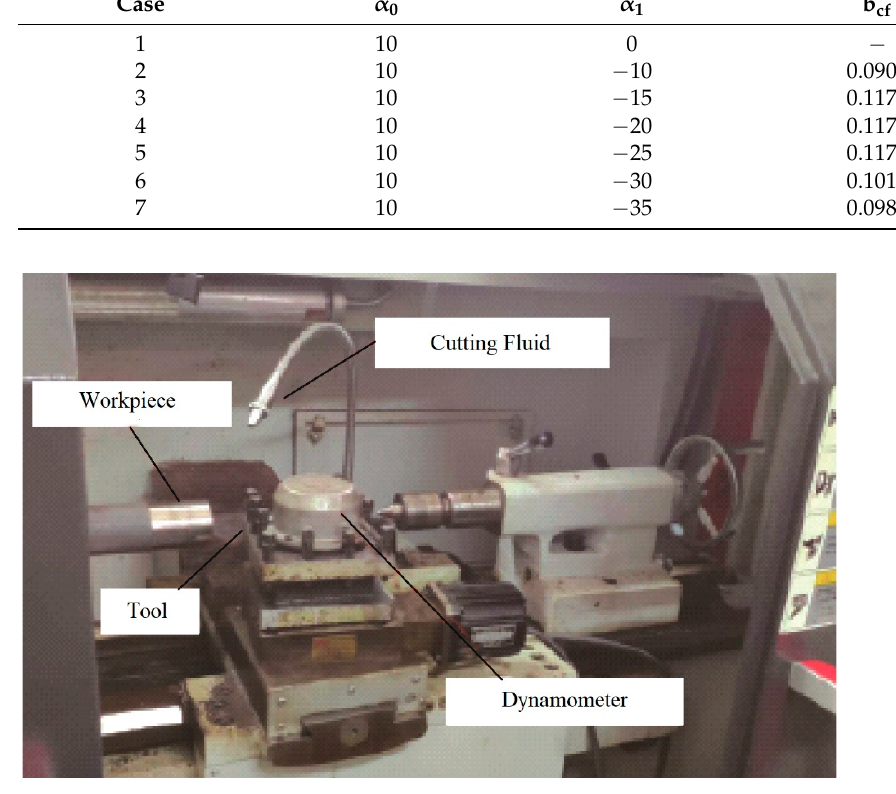
Figure 3. Experimental apparatus for measuring the cutting and thrust force [26].